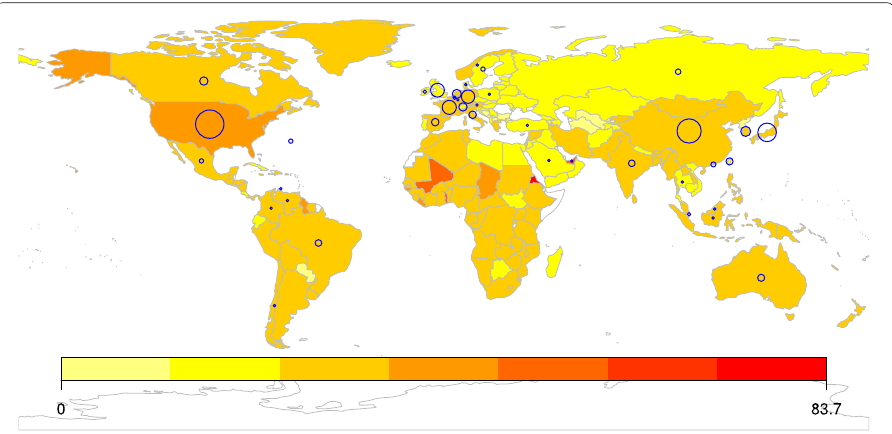
and “conduit” outward centralities, which were proposed and proved to be effective in identifying jurisdictions used for tax purpose by Garcia-Bernardo et al. (2017). Unlike the “sink” and “conduit” outward centralities, the “holding” company and “conduit” com-